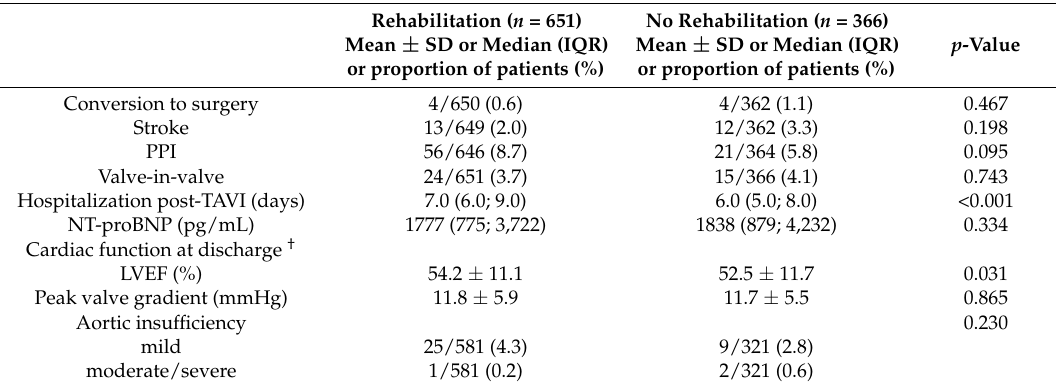
Table 2. Procedural and in-hospital outcomes.